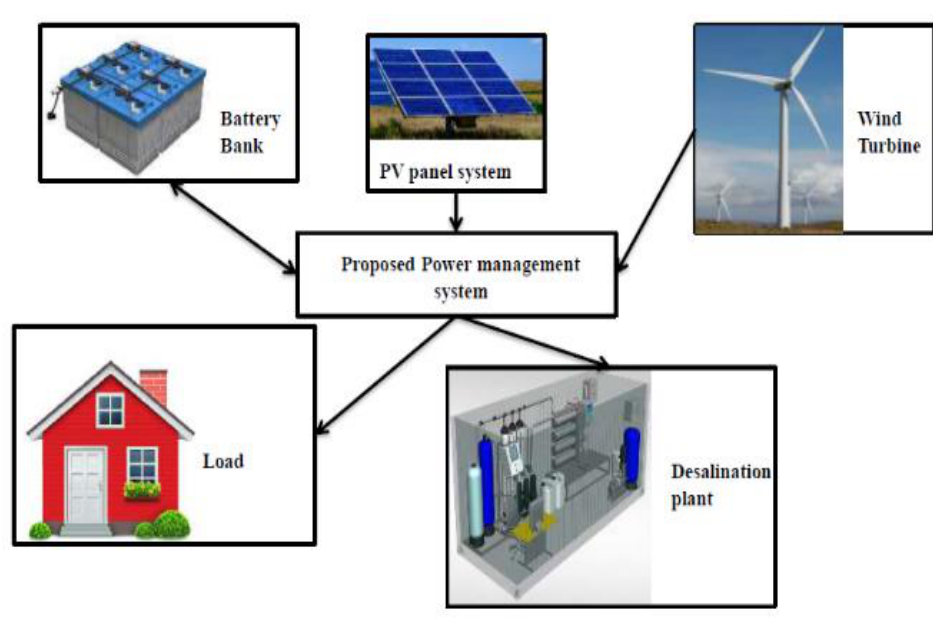
Figure 1. Proposed overlay of the hybrid energy system.